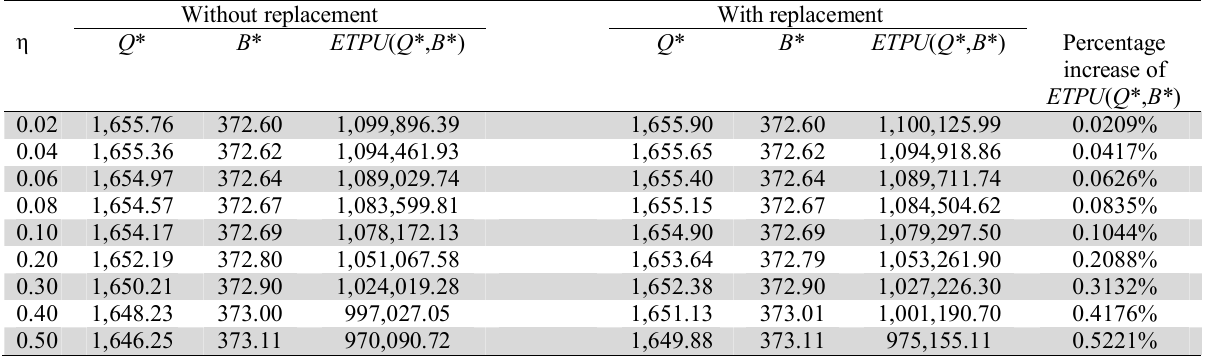
c = 500, c = 100, β= 0.04, λ= 0.04 a r